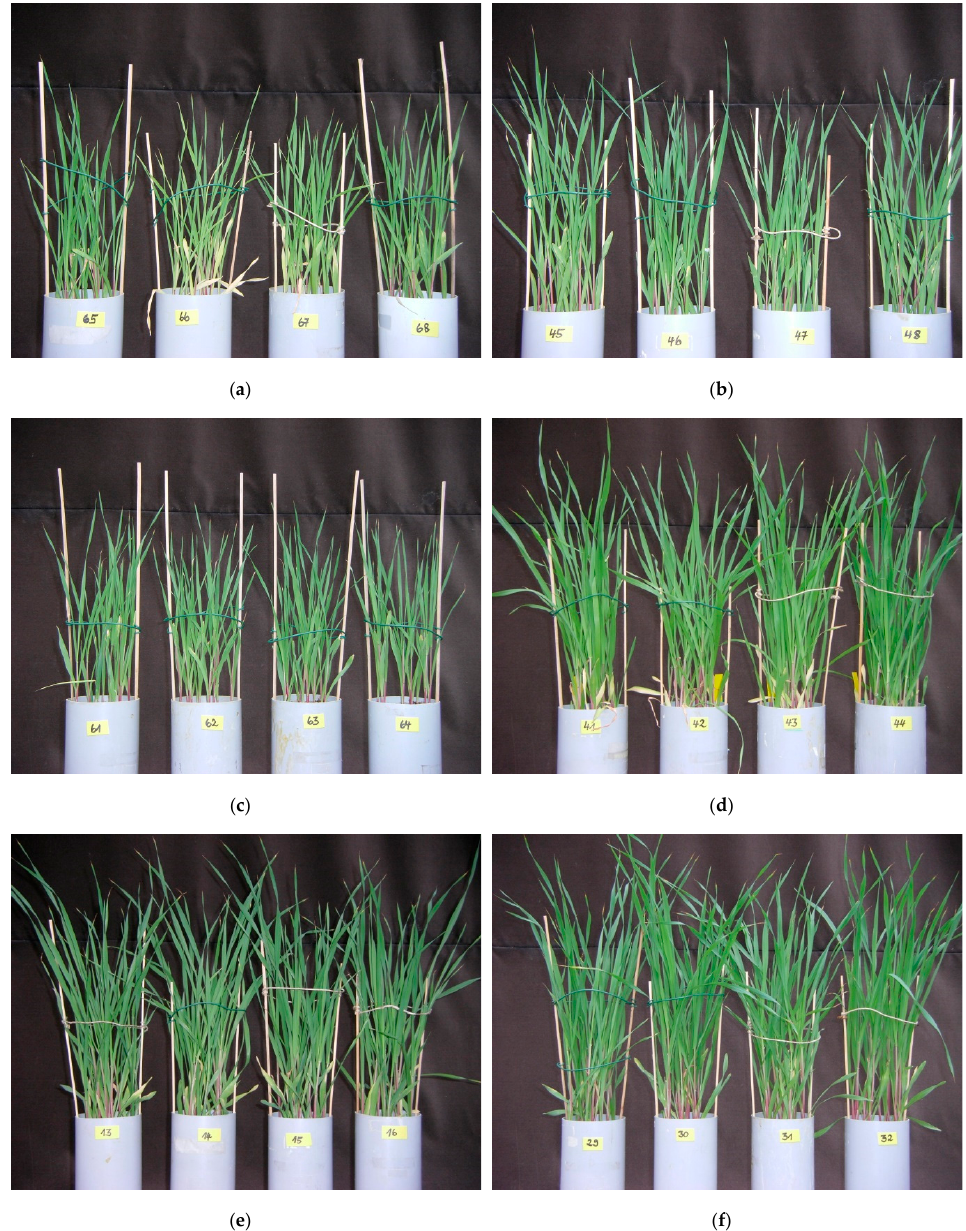
Figure 1. Barley plants 35 days after sowing with yellow leaf tips and violet discoloration of stalks: ( a ) Control (without digestate treatment); ( b ) Treatment SDD2L (solid digestate dried, biogas plant 2, low fertilization level); ( c ) Treatment SDD2H (solid digestate dried, biogas plant 2, high fertilization level); ( d ) Treatment SD2L (solid digestate, biogas plant 2, low fertilization level); ( e ) Treatment SDD1L (solid digestate dried, biogas plant 1, low fertilization level); (f) Treatment SDD1H (solid digestate dried, biogas plant 1, high fertilization